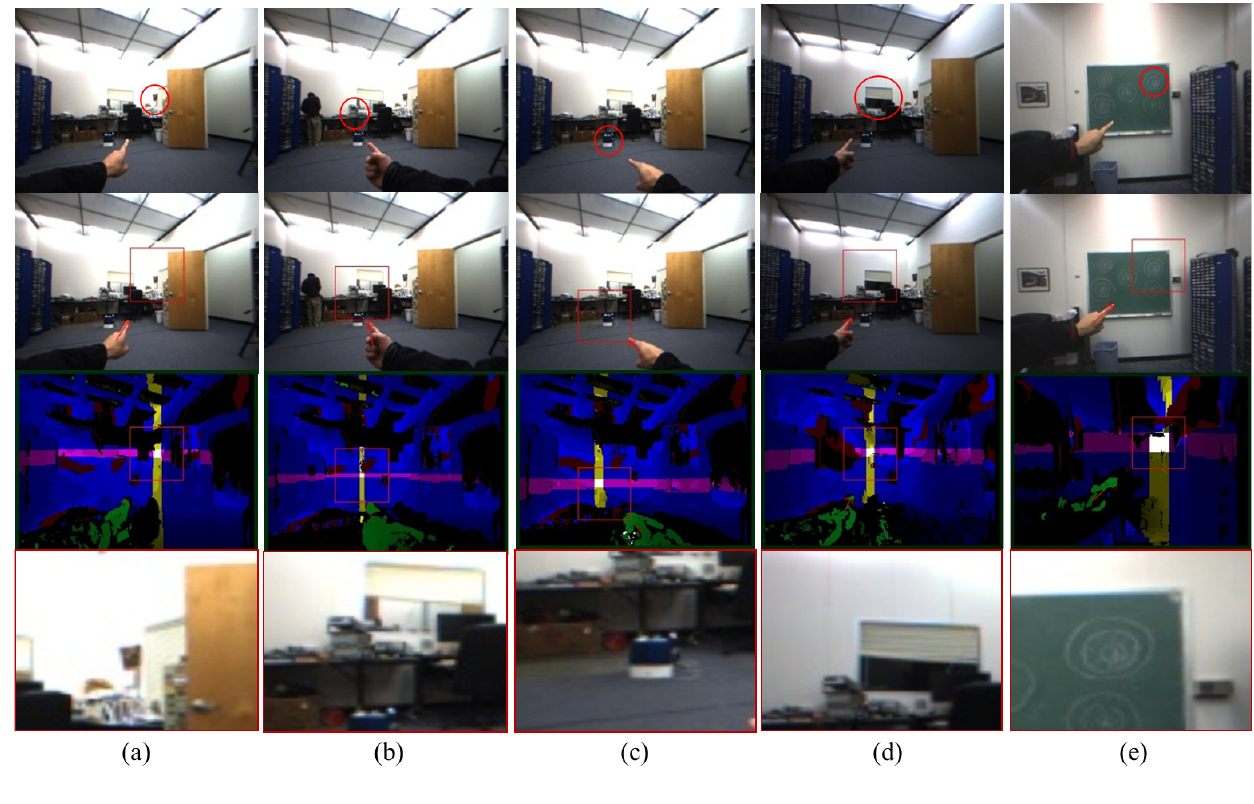
Figure 12. Results of object detection and magnification for ( a ) a calendar; ( b ) an instrument; ( c ) a humidifier; ( d ) a small window; ( e ) a drawn shape on a blackboard. Each row, from top to bottom, shows the sequential order for ROI extractions and the magnified ROI display.